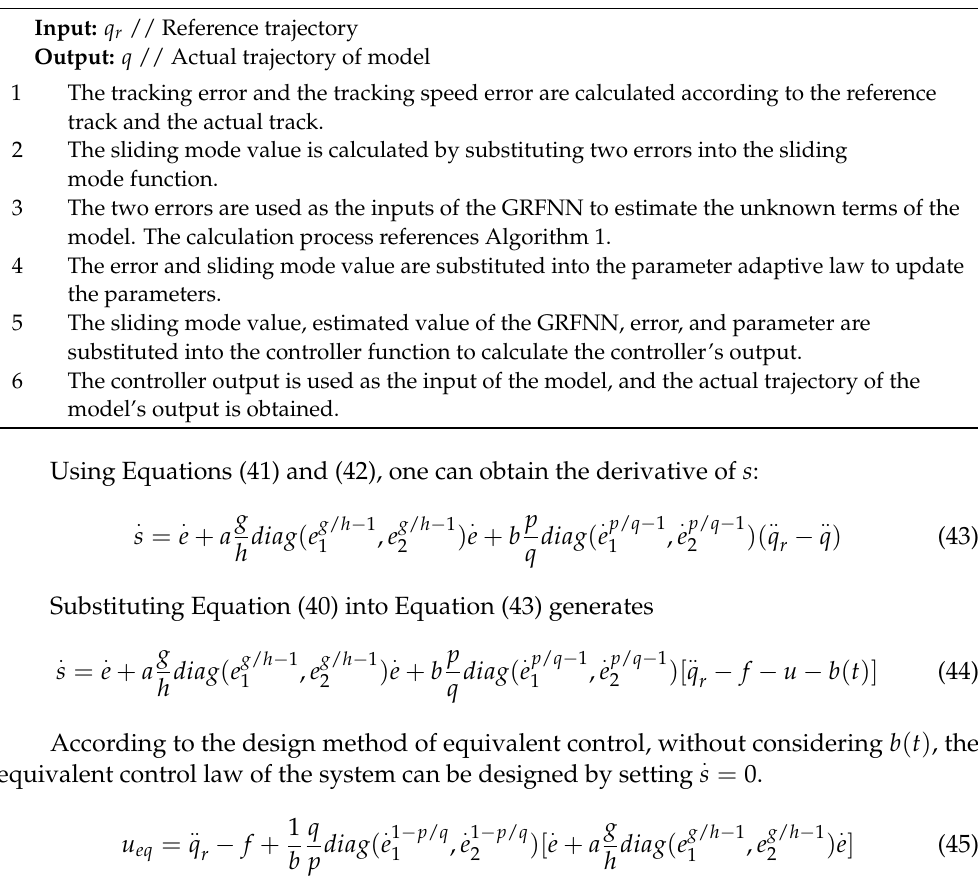
Figure 4. The block diagram of NFTSMC using a GRFNN for a micro gyroscope (Algorithm 2). Algorithm 2: The calculation process of the control system